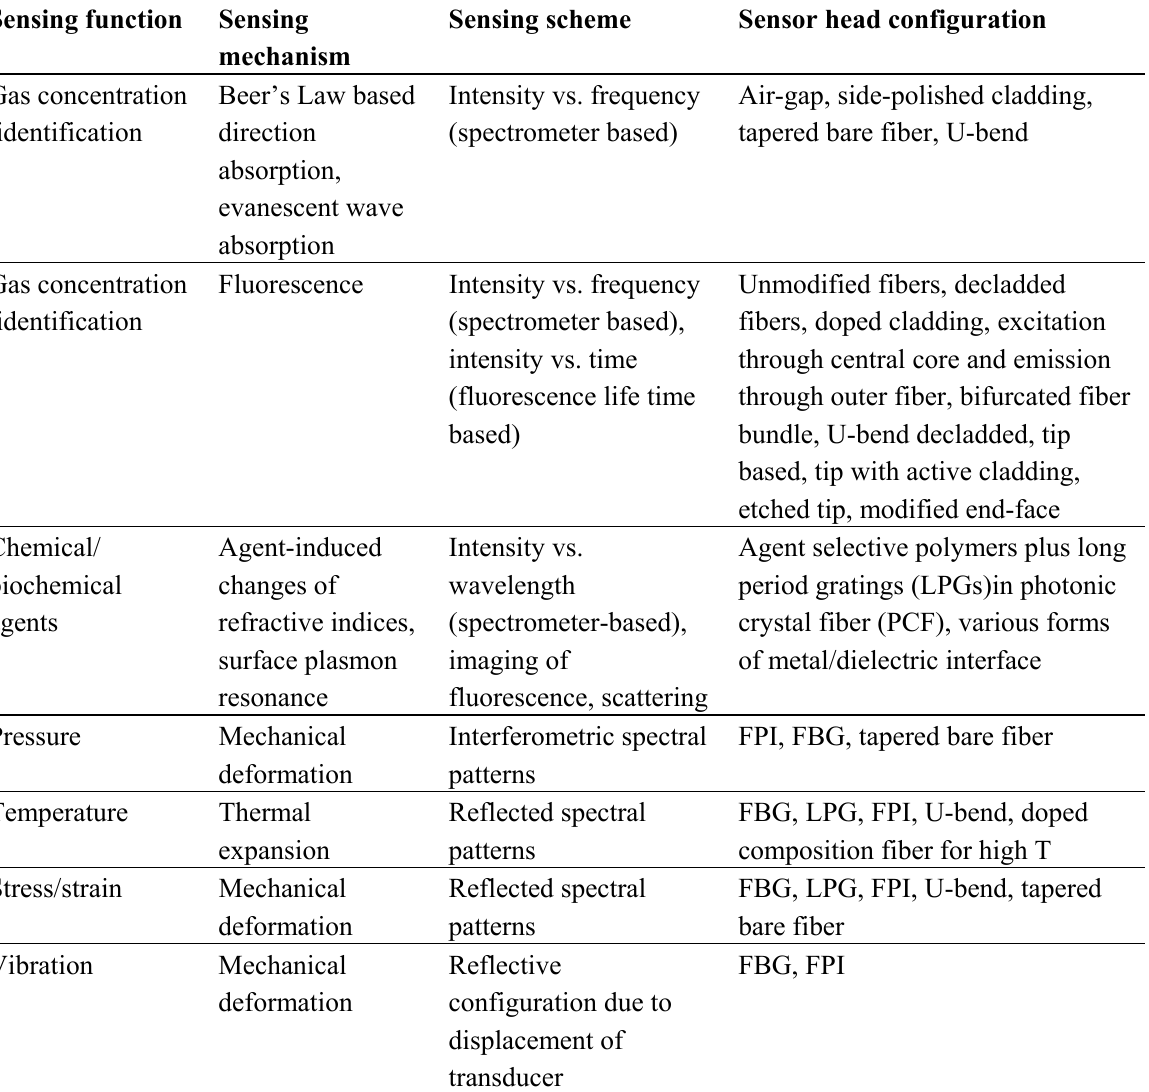
Table 1. Current FOS in terms of sensing functionalities, sensing mechanisms, and sensing